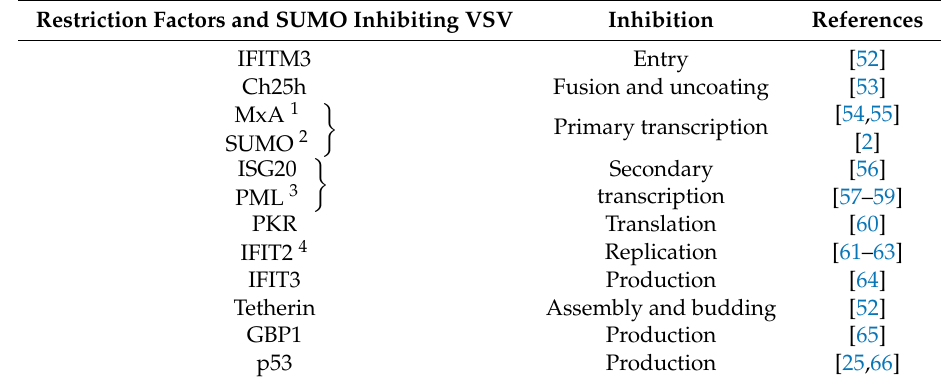
Table 1. Steps of the VSV life cycle inhibited by restriction factors and